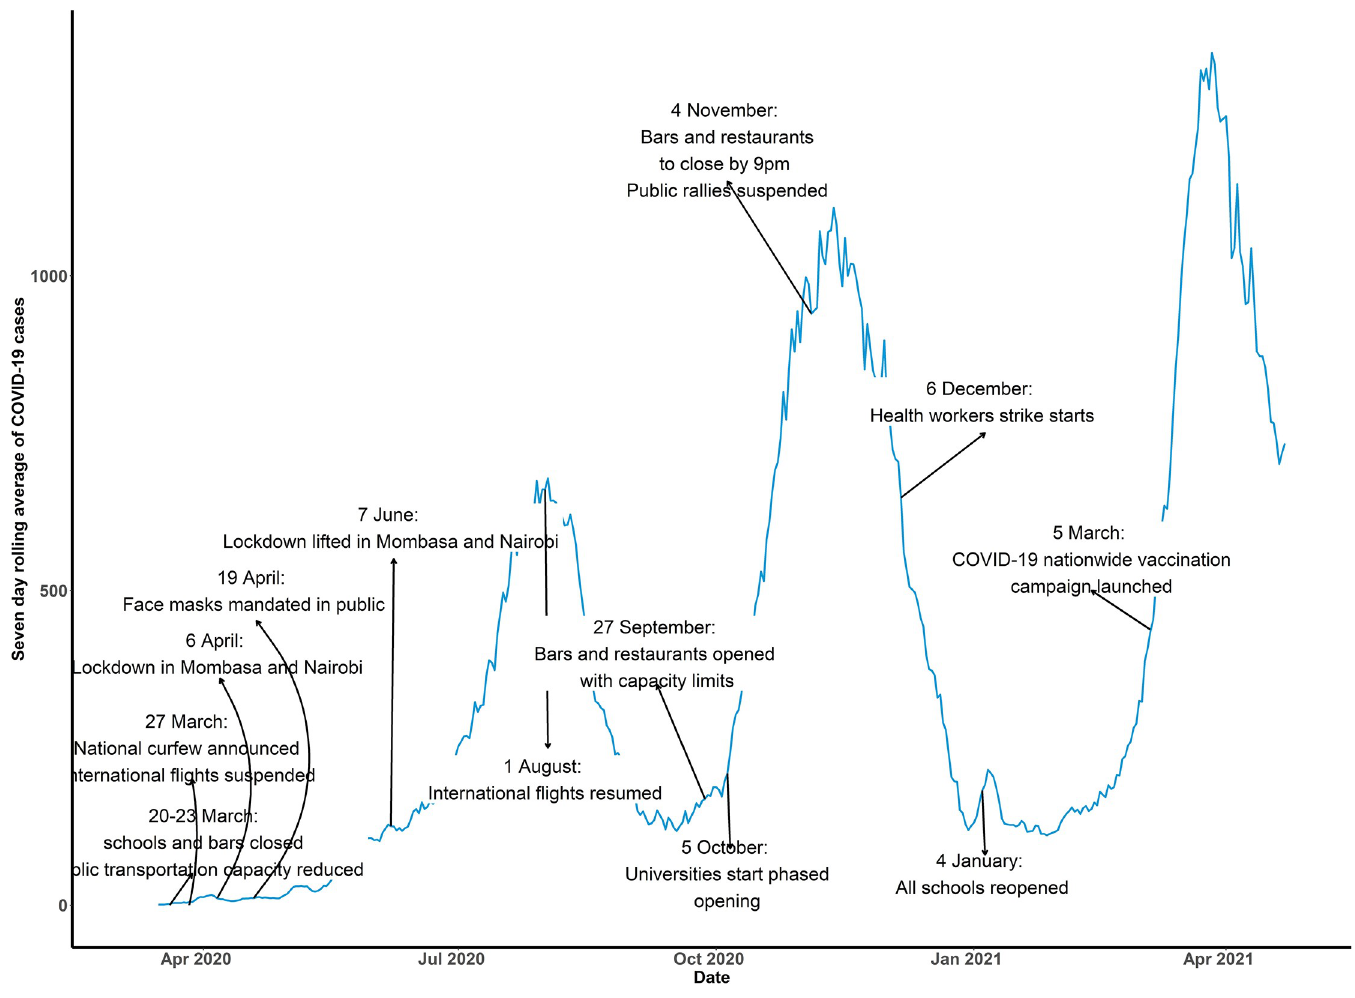
Fig 1. COVID-19 control measures timeline during the period of